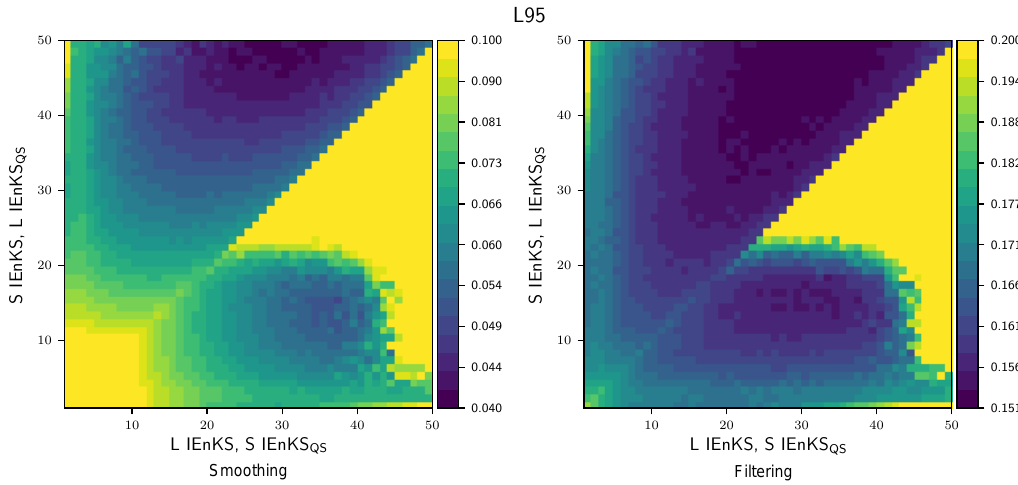
Figure 8. IEnKS (lower triangles) and IEnKS QS (upper triangles, N Q = S ) smoothing and filtering aRMSEs as a function of L and S with the L95 model. The L parameter is on the abscissa axis for the IEnKS and on the ordinate axis for the IEnKS QS . The S parameter is on the abscissa axis for the IEnKS QS and on the ordinate axis for the IEnKS. For readability, smoothing RMSE beyond 0.10 and filtering RMSE beyond 0.20 are in the same color and the scale is logarithmic.